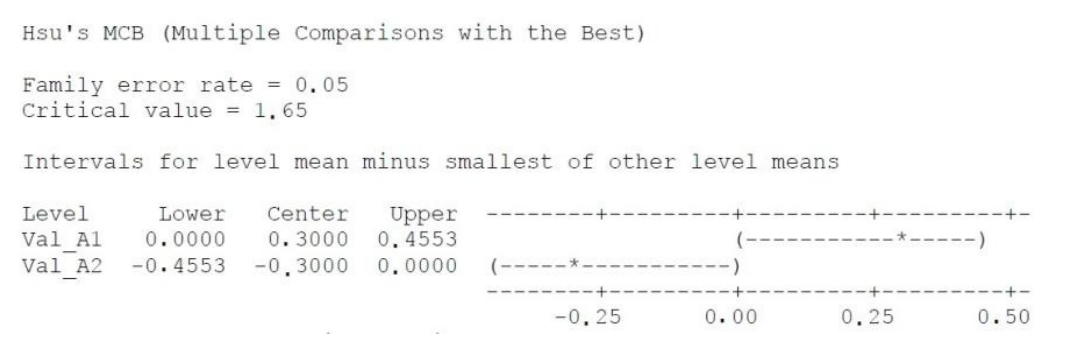
Figure 5. Hsu’s MCB method creates a confidence interval for the difference between each level mean and the best of the remaining level means. There is a statistically significant difference between the corresponding means. *—the OUTLIER- an unusually large or small observation. Values beyond the whiskers are outliers.